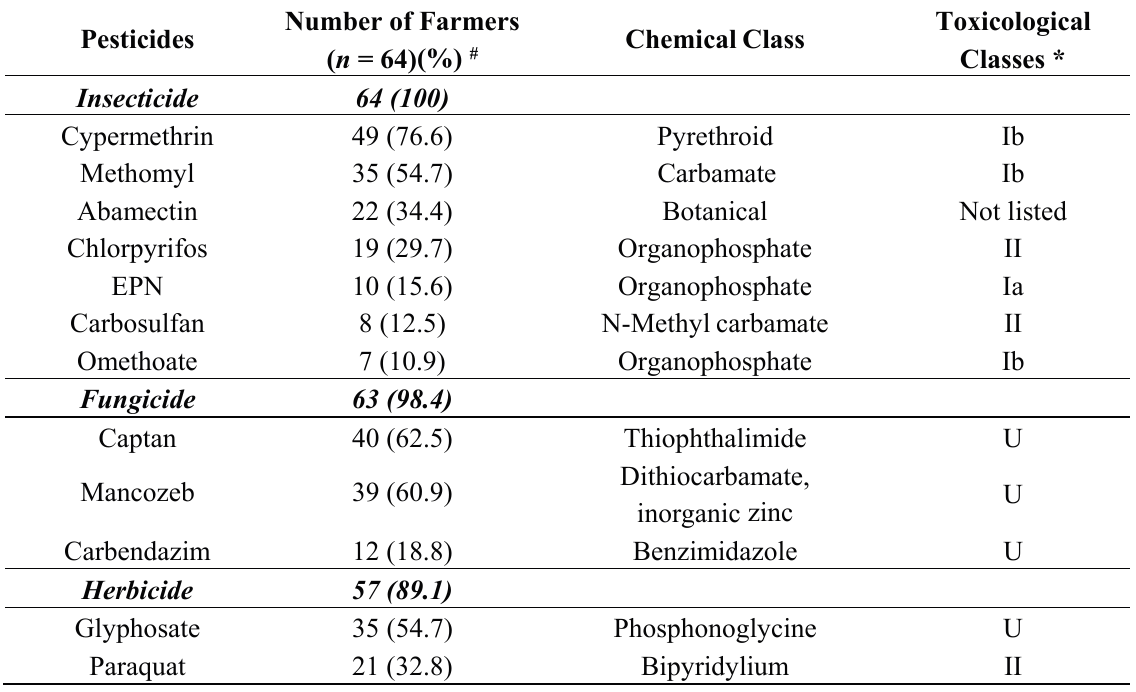
Table 2. Main pesticides used in orchid farms in the study